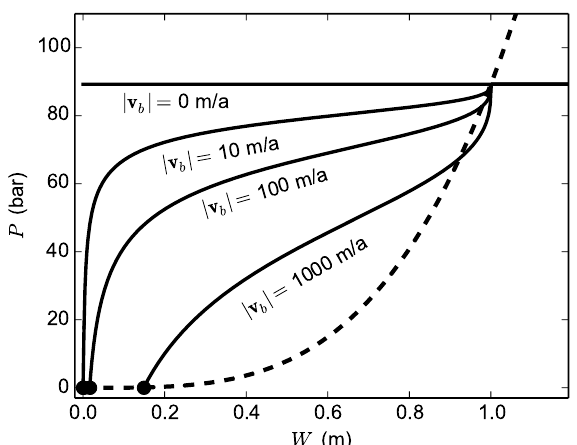
Figure A1. The steady-state function P(W) defined by Eq. (A3), using W r = 1m and H = 1000m (solid curves). Values of W c are indicated by black dots at P = 0. For comparison, Flowers and Clarke (2002a) relation Eq. (28) is shown with W crit = 1m (dashed black).